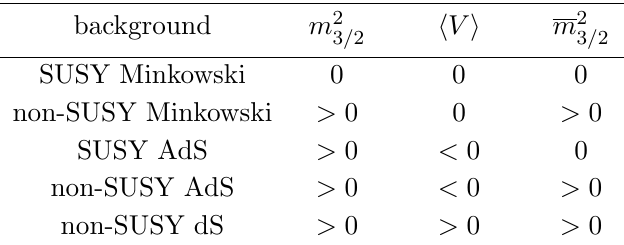
Table 2 . Overview of four-dimensional vacuum con(cid:12)gurations in N = 1 supergravity coupled to chiral supermultiplets with the corresponding apparent gravitino mass, vacuum energy and e(cid:11)ective gravitino